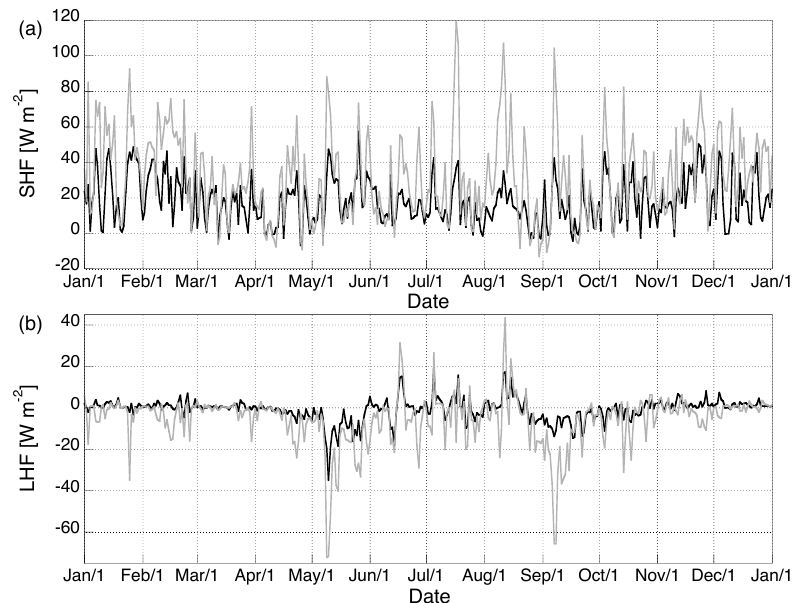
Fig. 14. Comparison of simulated (gray lines) and observational based (black lines) daily averaged surface (a) sensible heat flux SHF, and (b) latent heat flux LHF in [Wm − 2 ] at S6 for the year 2004.